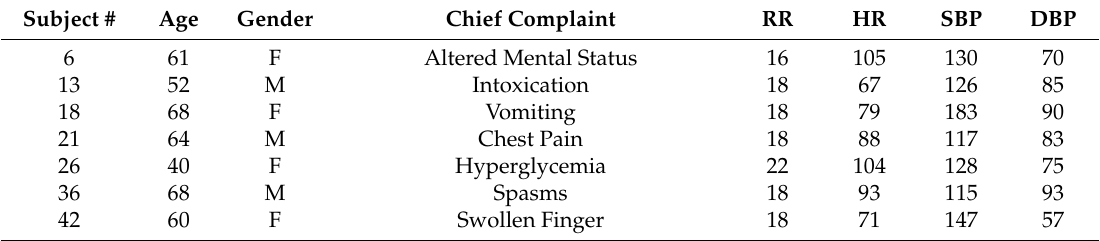
Table 3. Presence of under-triage (EP disagreement with EMTs for UCC